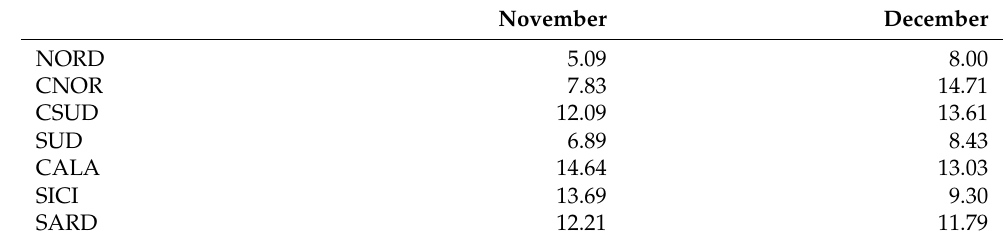
Table 1. MAPE (%) for the GBM predictions of November and December.